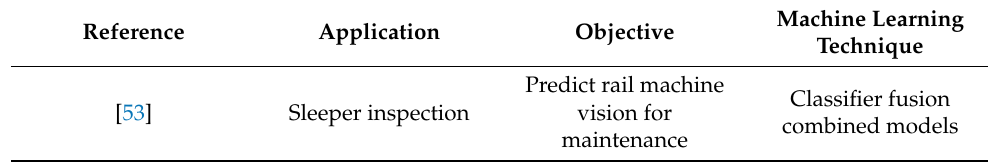
Table 2. Recent applications of machine learning methods for railway tracks. Adapted from